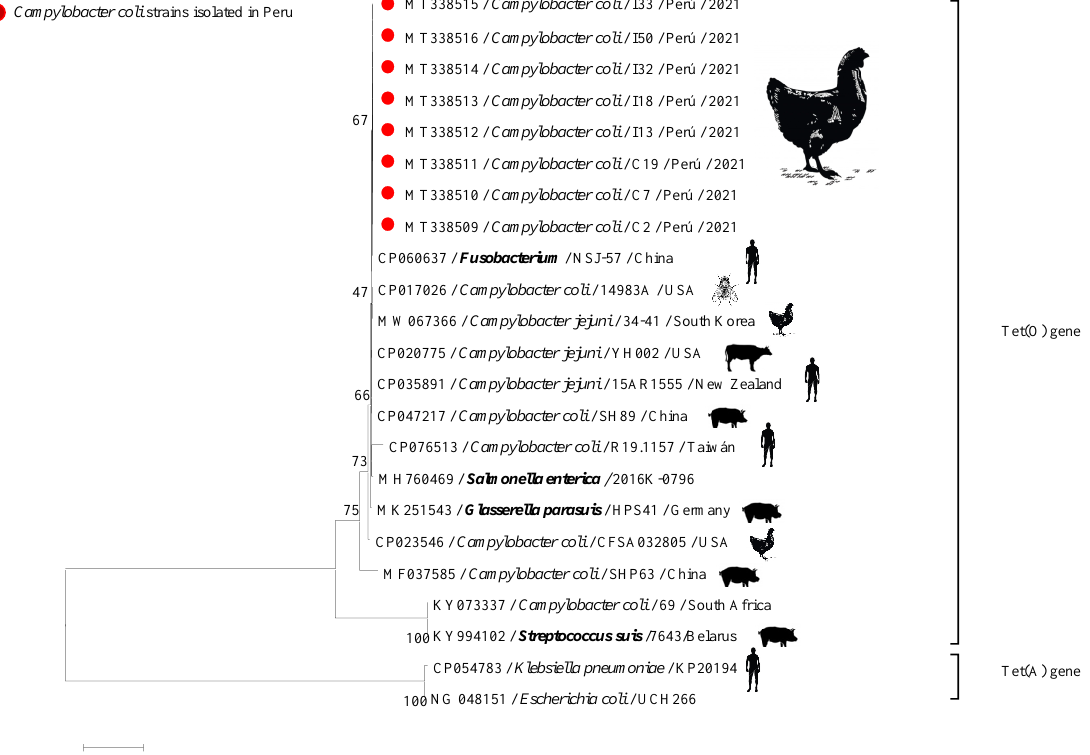
Figure 1. Phylogenetic tree constructed from nucleotide sequences (559 bp) of the Tet(O) gene from Campylobacter coli strains. Obtained sequences were aligned and compared with sequences of the genes encoding the Tet(O) and Tet(A) proteins expressed in different genera and species of bacteria isolated from different animal species. The genetic region used for detecting Tet(O) was found to be highly conserved among those reported for different genera and species, with a phylogenetic distance in the range of 77.9% to 100% nucleotide identity. When aligning Tet(O) and Tet(A) sequences, a nucleotide identity of between 41% and 43.6% is observed. Calculated phylogenetic distances were corrected using the parameter Kimura-2 model. The dendrogram was performed with the neighbor- joining method. Statistical support was performed by bootstrapping of 1000 replicates. Bootstrap values greater than 75% occur at nodes and branches. The distance scale is in substitutions/site. The red circles indicate the Peruvian strains of Campylobacter coli that express the Tet(O) gene. The eight analyzed sequences were submitted to GenBank with the accession numbers MT338509 to MT338516 .